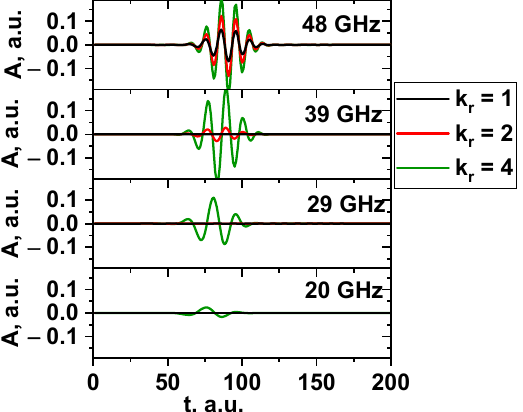
Figure 27. DBS signals for several probing frequencies. The circular (black line), slightly stretched with 1:2 proportions (red line), and very stretched with 1:4 proportions (green line) filaments are presented. When analyzing the dependency of the signal amplitude, frequency, and velocity